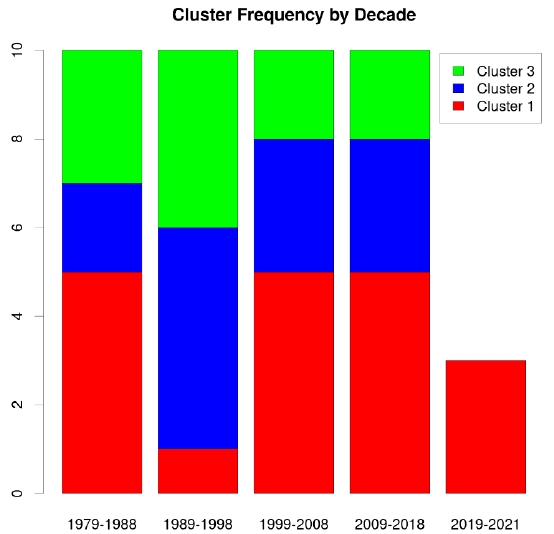
Figure 5. Frequency of each cluster’s members by decade. The frequency of each cluster’s occurrence was highly consistent by decade with the exception of 1989 – 1998.